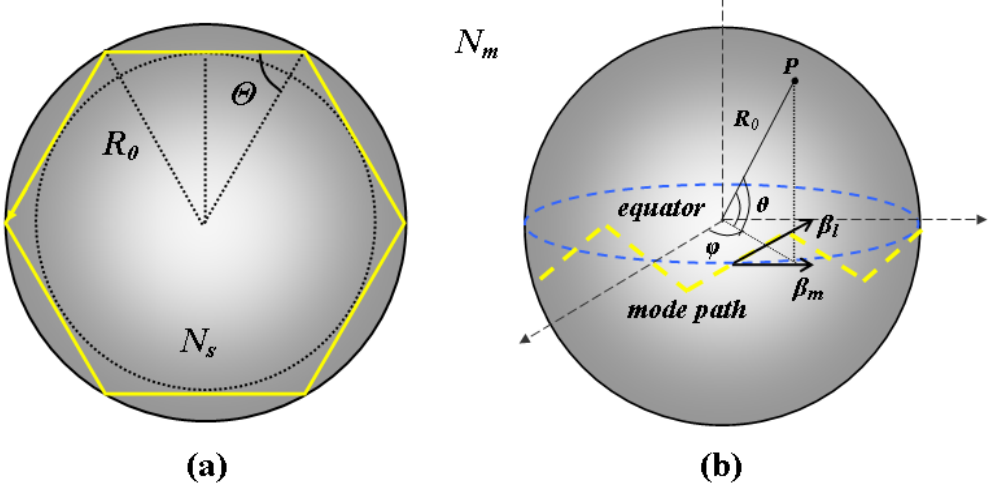
Figure 1. (a) Total internal reflection for the light rays in correspondence of the surface of the microsphere; (b) Spherical coordinate system and mode propagation along the equatorial plane of the